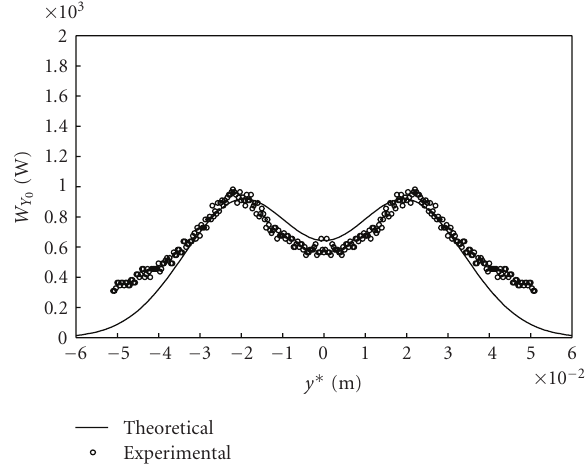
Figure 16: Heat flux distribution with a rectangular magnetic field. Y 0 is assumed as 2 . 2 × 10 − 2